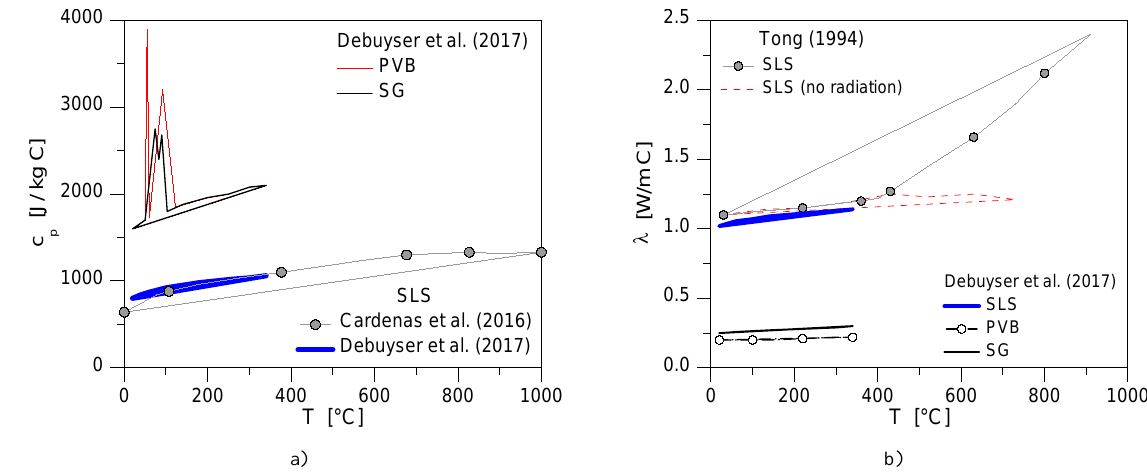
Fig. 3 Thermal properties of glass, as a function of temperature: a) specific heat and b) conductivity.